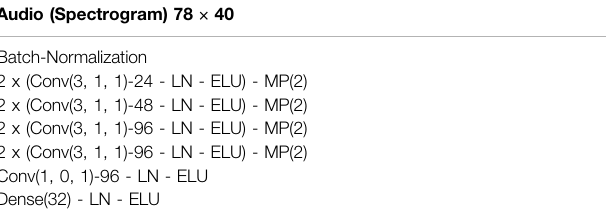
TABLE 2 | CNN spectrogram encoder. Conv( f , p , s )- k denotes a convolutional layer with k f × f kernels, padding of p and stride s . We use layer normalization (LN) (Ba et al., 2016), the ELU activation function (Clevert et al., 2016) and max pooling (MP) with a pool size of 2 × 2. For input normalization we use a batch normalization (Ioffe and Szegedy, 2015) layer, to learn mean and standard deviation parameters for each frequency band similar to (Grill and Schlüter, 2017). Note that there are no af fi ne transformation parameters c and β in this normalization layer.